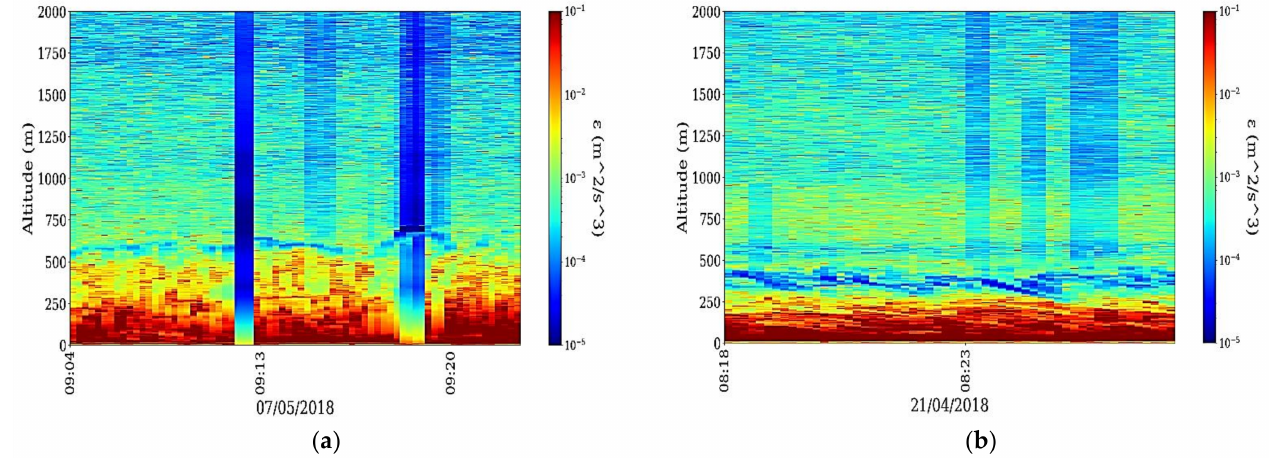
Figure 10. (cid:104) ε (cid:105) timeseries: ( a ) 07 May 2018, 15 s temporal resolution; ( b ) 21 April 2018, 10 s temporal resolution.